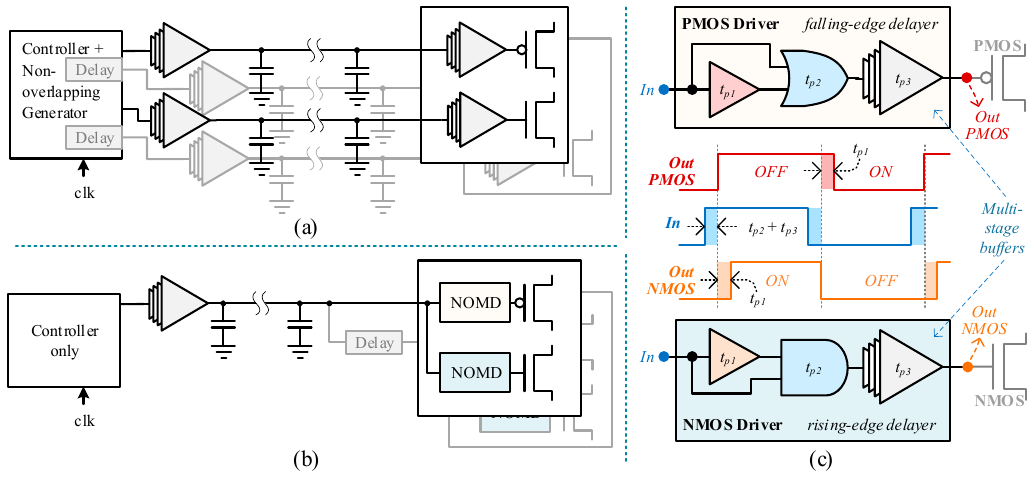
Figure 4. ( a ) Conventional non-overlapping architecture; ( b ) proposed non-overlapping architecture with reduced buffers and wires; ( c ) proposed non-overlapping MOSFET drivers with edge-delaying.